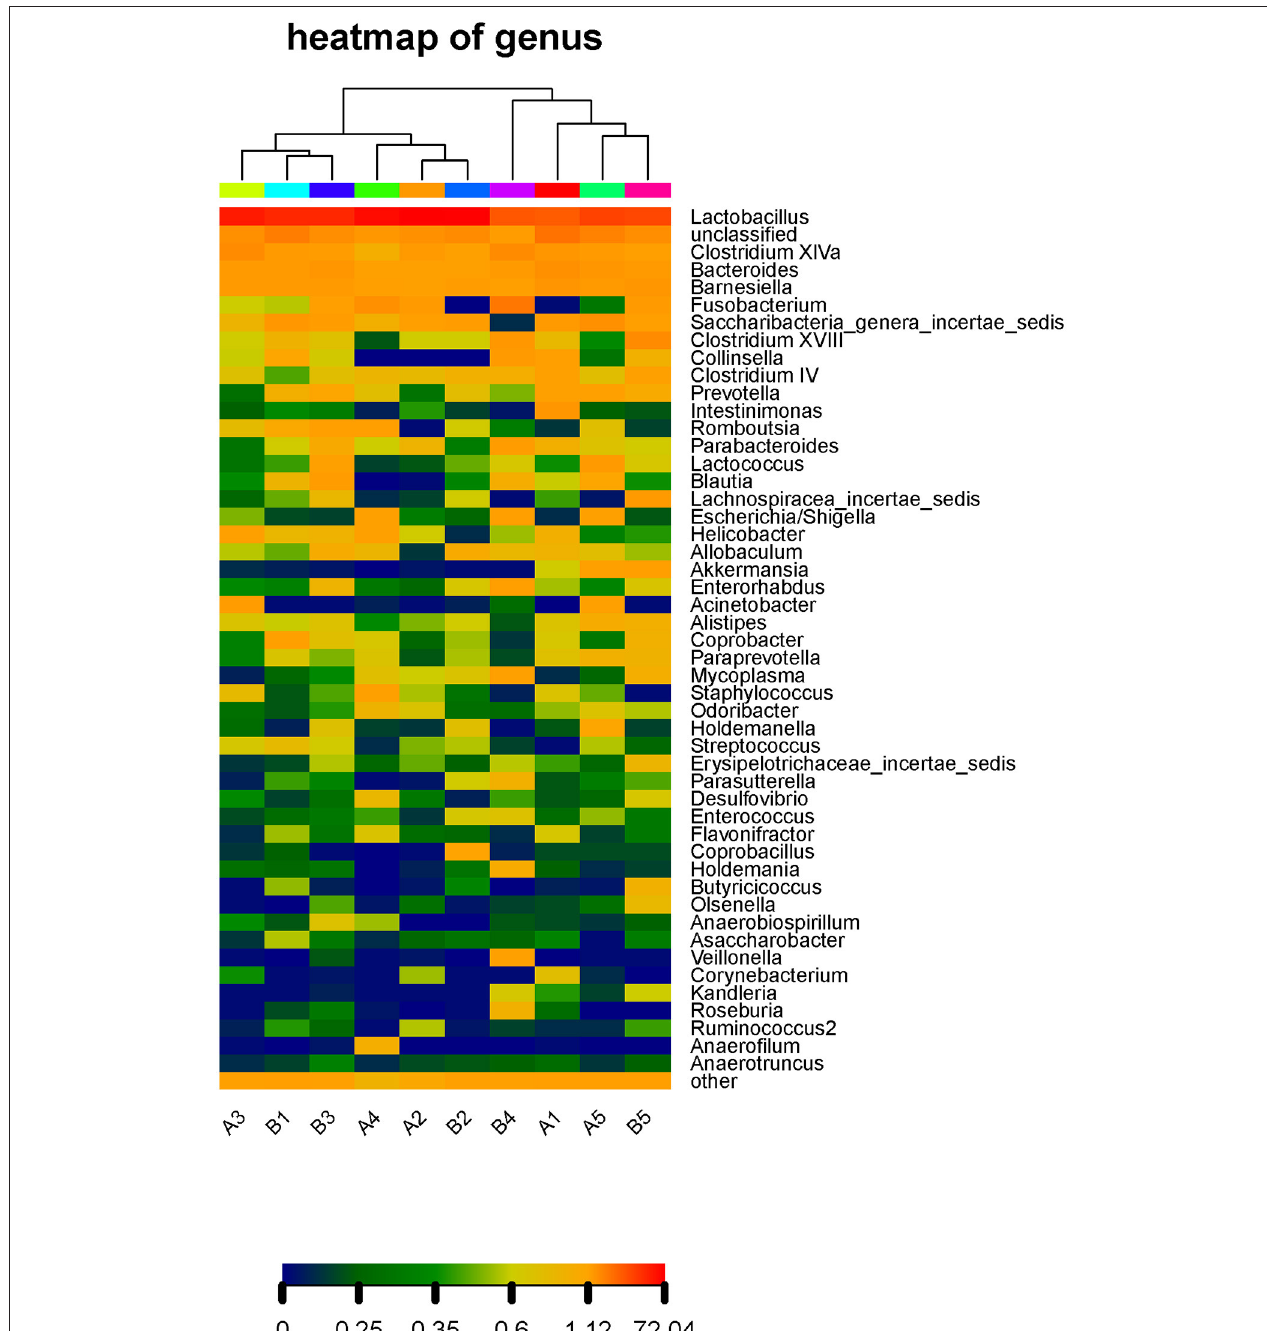
FIGURE 6 | Thermal map of species abundance at the genus level in the intestinal microflora of mice. The abundance distribution of the taxa of the microbiota at different taxonomic levels, a heat map of species abundance was built for the microbiota with the top 50 relative abundance values in the gut microbiota of our mice and the rest of the species are grouped into Other. The horizontal axis is the number of each sample, and the vertical axis is the relative abundance ratio. Each column represents a sample, rows represent community structure, and color blocks Represents the relative species abundance value, the red color means the higher the relative abundance, the blue color and vice versa. In addition, the heat map is aggregated on the sample, the more similar the distribution of sample flora is, the closer the sample distance is, and the closer the position in the cluster tree at the top of the figure is., which is shown at the top of the graph. The samples from the same group are the same